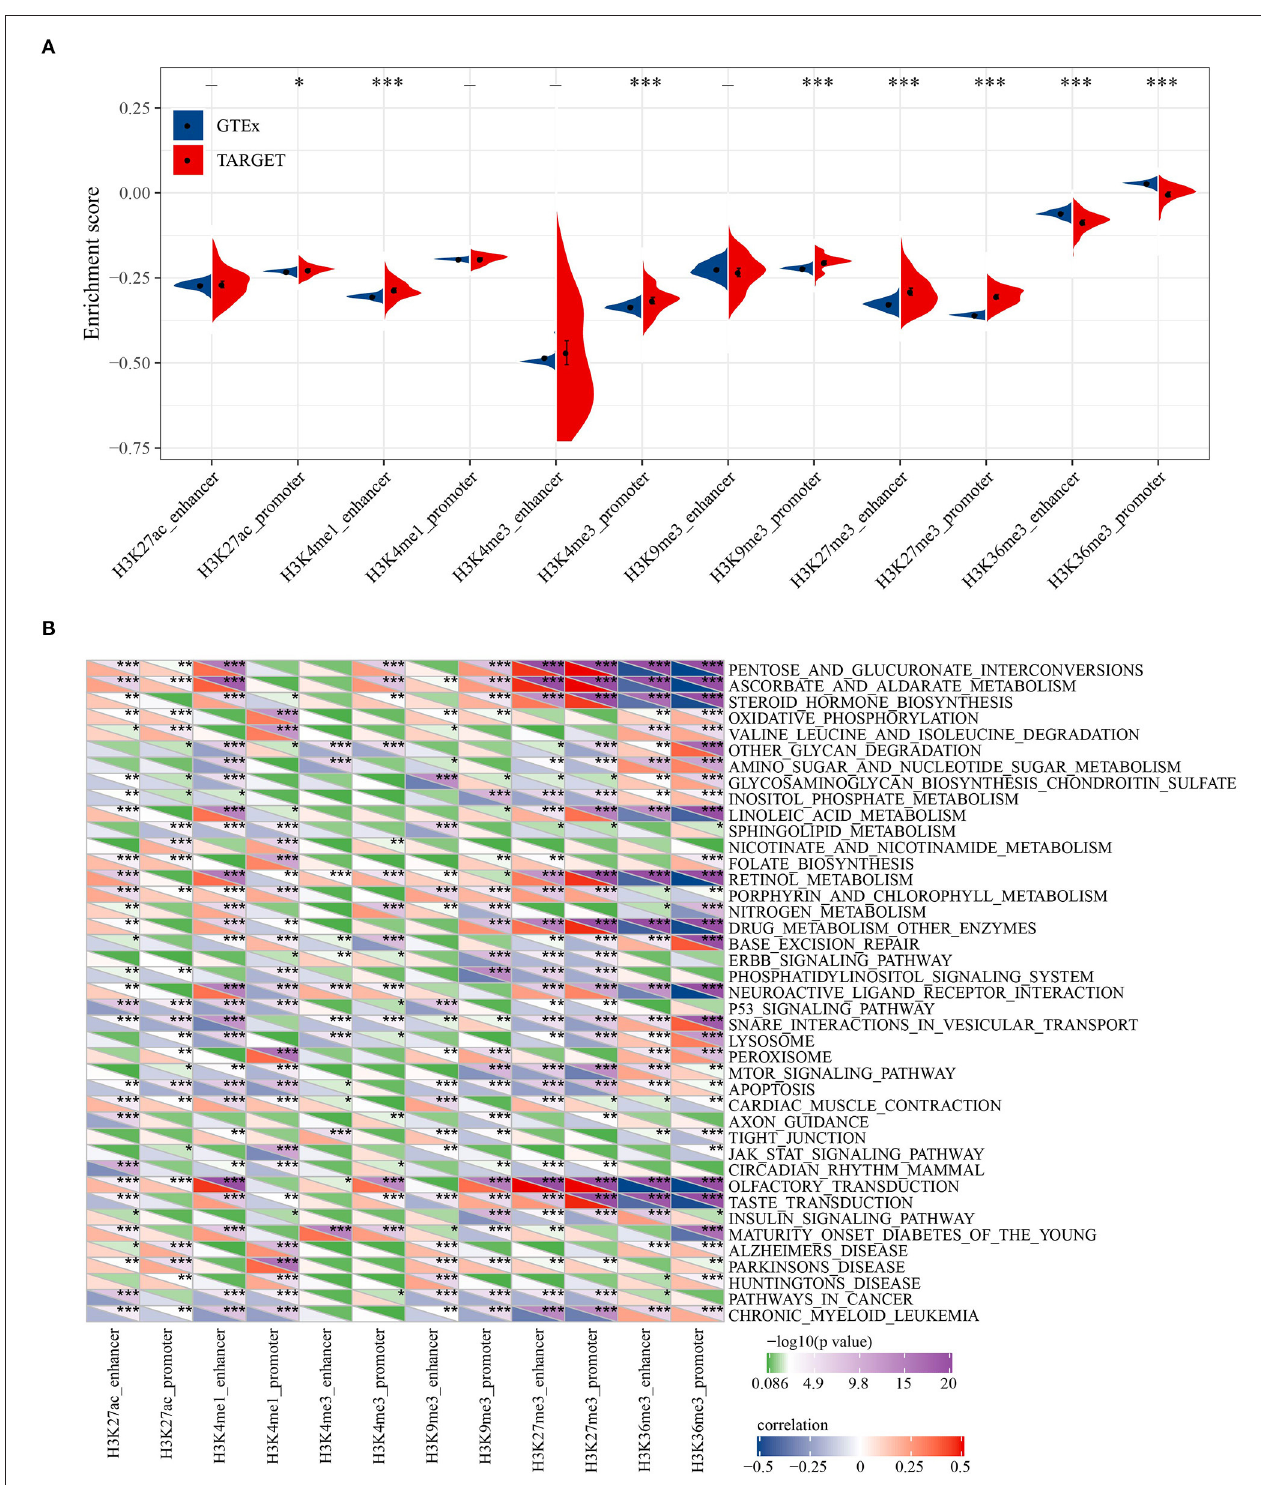
FIGURE 2 | Biological characteristics of histone modification regulation. (A) The difference for enrichment scores of six histone modified promoters and enhancers between normal samples and osteosarcoma samples. (B) Correlation between KEGG pathway and six histone-modified promoters and enhancers. * P < 0.05, ** P < 0.01, *** P <